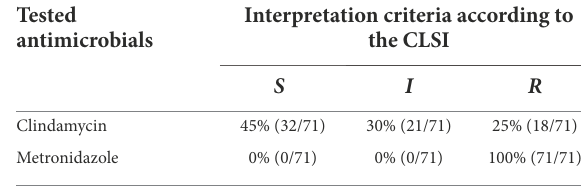
suggested by the Clinical and Laboratory Standards Institute